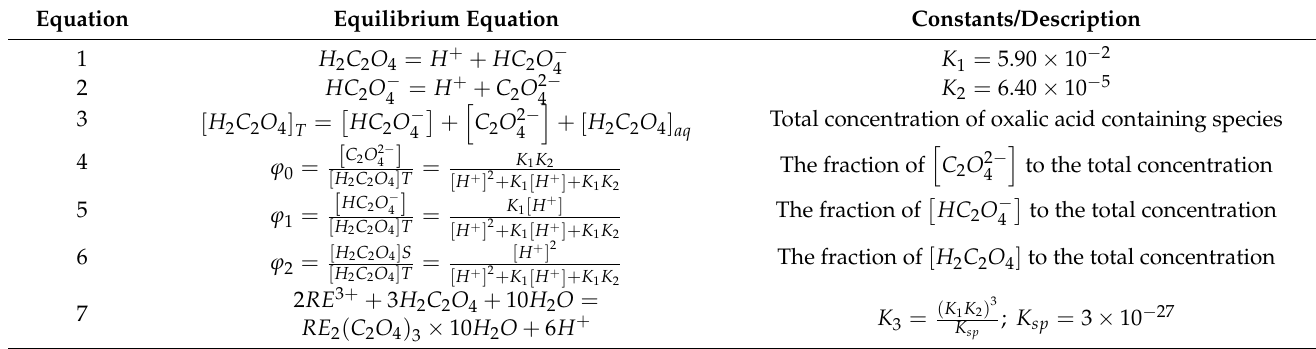
Table 3. The equilibrium equations, solubility constants and species distribution for oxalic acid